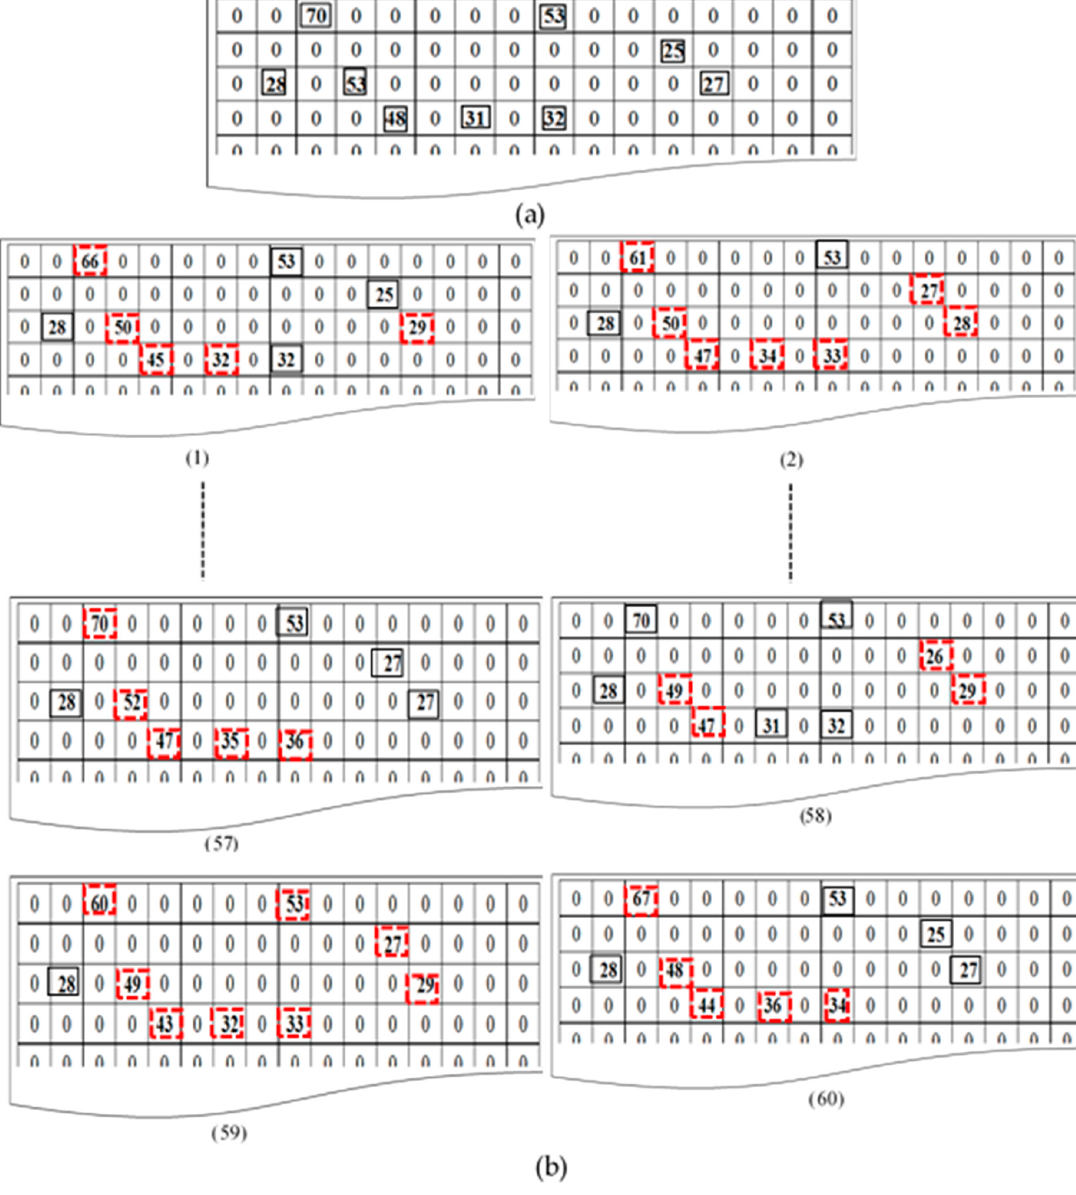
Figure 4. Scheme 2 augmentation. ( a ) RSSI data set without augmentation. ( b ) For N = 60, there are a total of 60 augmented RSSI data sets with mean and uniform random numbers. The solid black boxes represent the original RSSI value and the dotted red boxes represent augmented RSSI values.